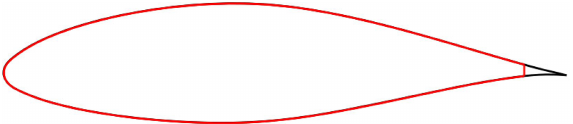
Figure 2. NACA 65 4 -421 profile manufactured in red and the the- oretical trailing edge in